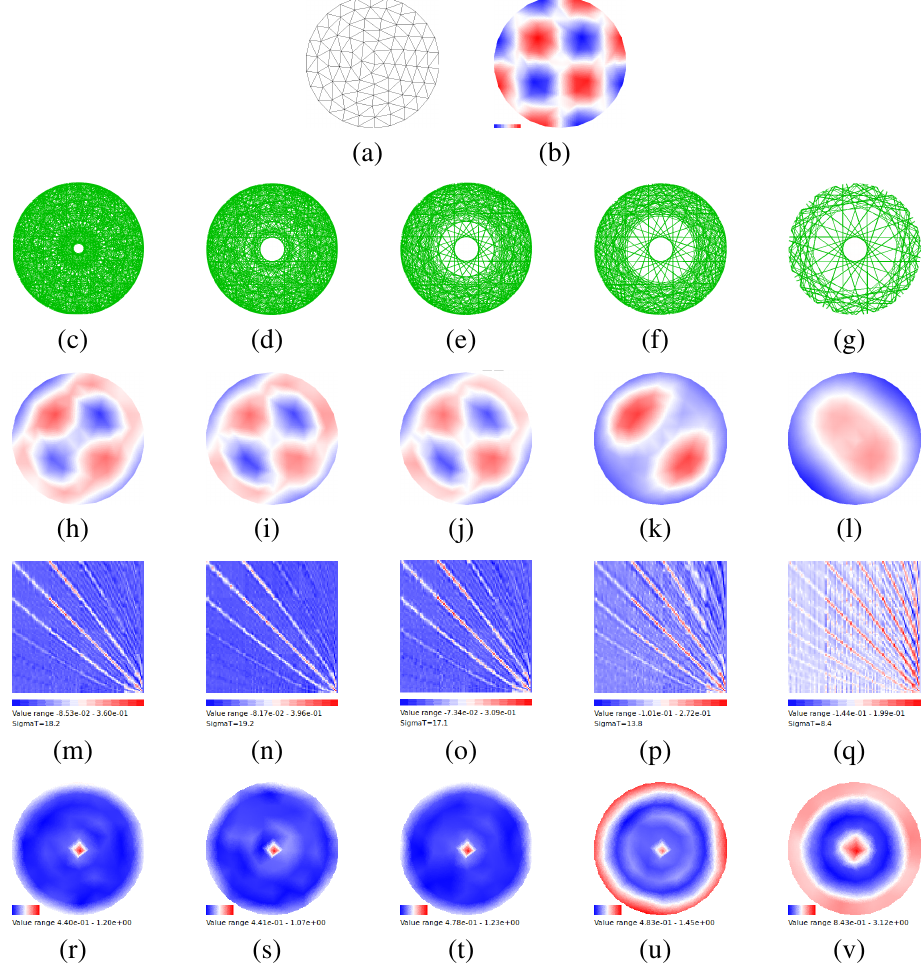
Figure 4. Resolution and resolvability as a function of ray coverage for multiple beam model. Frame descriptions are the same as in Fig.